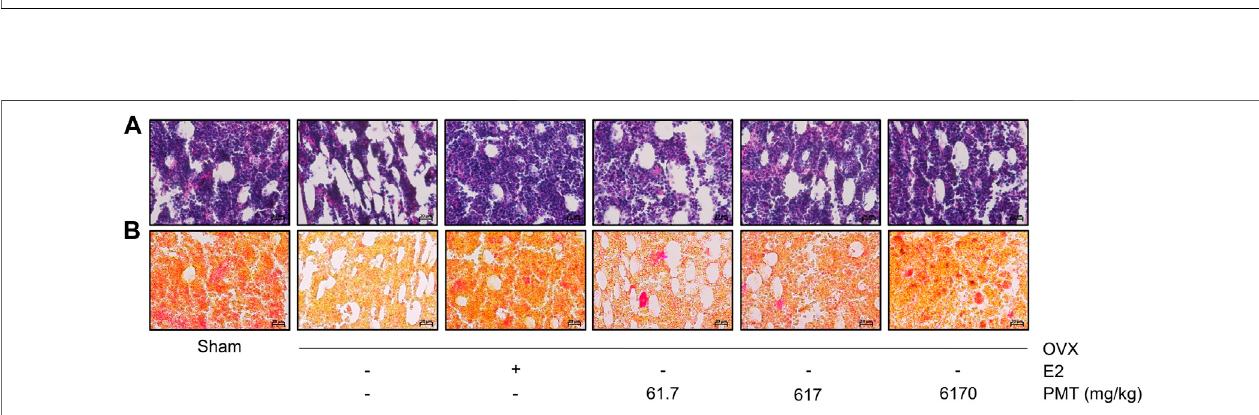
FIGURE 1 | Effects of PMT on BMC and BMD in osteoporotic mice. Bone mineral content and bone mineral density of tibiae, femora and lumbar vertebrae were analyzed by DXA. (A) Levels of bone mineral content in tibia, femur and LV. (B) Levels of bone mineral density in tibia, femur and LV. Results are presented as mean ± standard error of the mean. # p < 0.05, ## p < 0.01 and ### p < 0.001 vs. Sham group; * p < 0.05, ** p < 0.01 and *** p < 0.001 vs. OVX group. OVX, ovariectomized group; E2, 17 β -estradiol group; PMT, Palmul -tang soft extracts; LV, lumbar vertebrae; BMC, bone mineral content; BMD, bone mineral density.